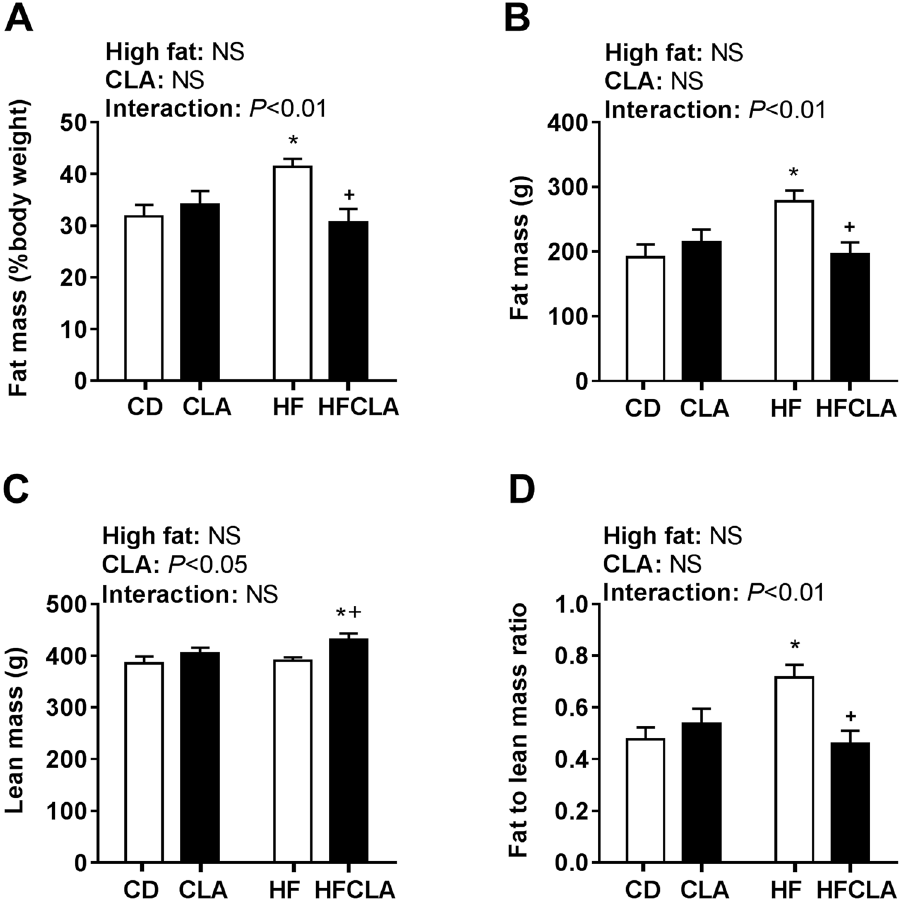
Figure 2. Offspring body composition. Body composition was determined by DXA. (A) Fat mass expressed as a percentage of body weight (B) fat mass in grams (C) lean mass in grams and (D) fat mass to lean mass ratio. Data expressed as means ± SEM ( n = 5–6 litters/group), where * P < 0.05 vs CD and + P < 0.05 vs